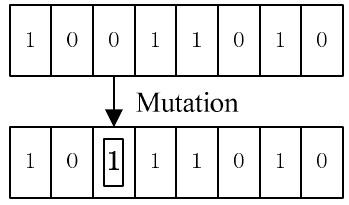
Figure 7. Schematic diagram of mutation.